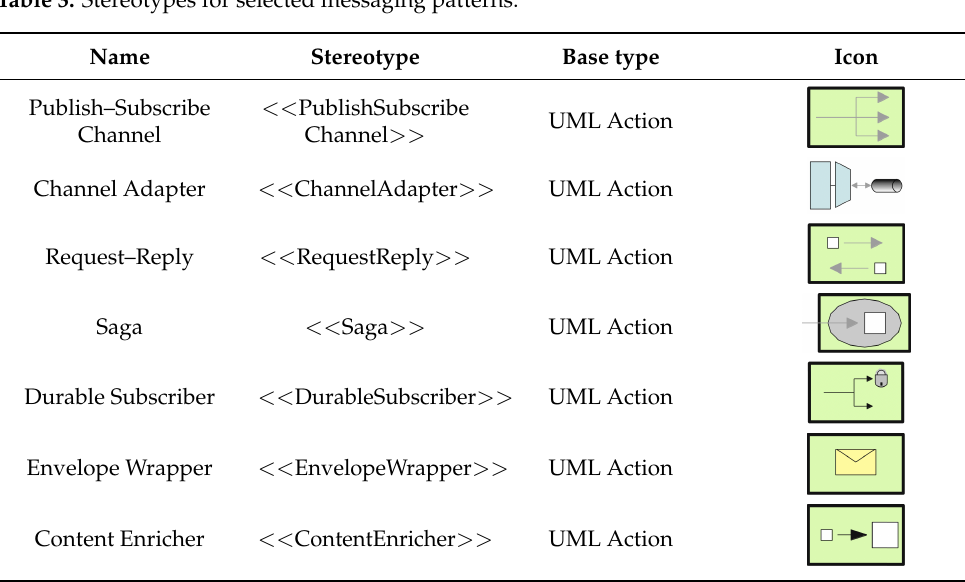
Table 3. Stereotypes for selected messaging